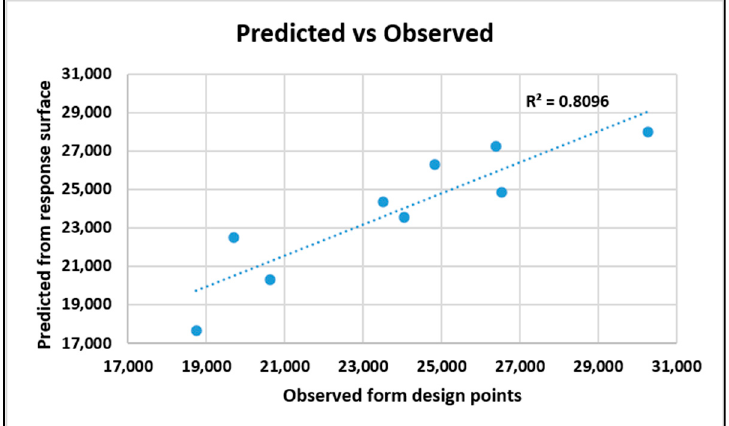
Figure 25. Goodness of fit for improved system from tensile response.